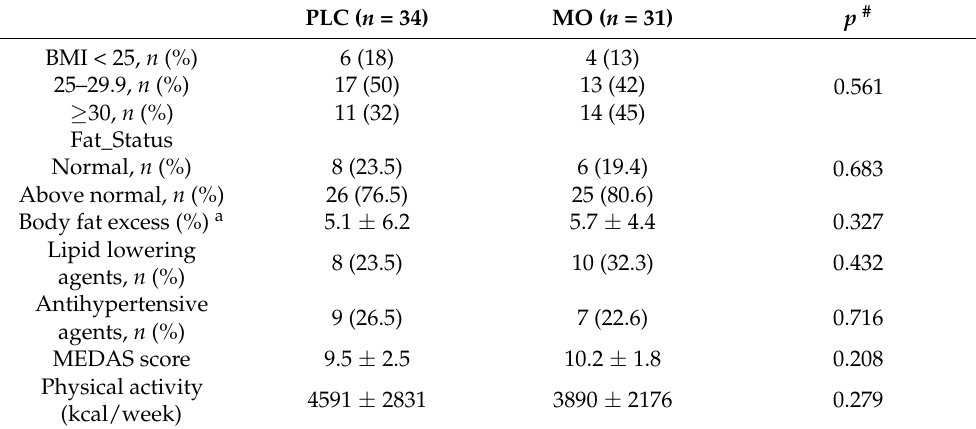
Table 1. Basal characteristics and medication prescribed in the study participants.